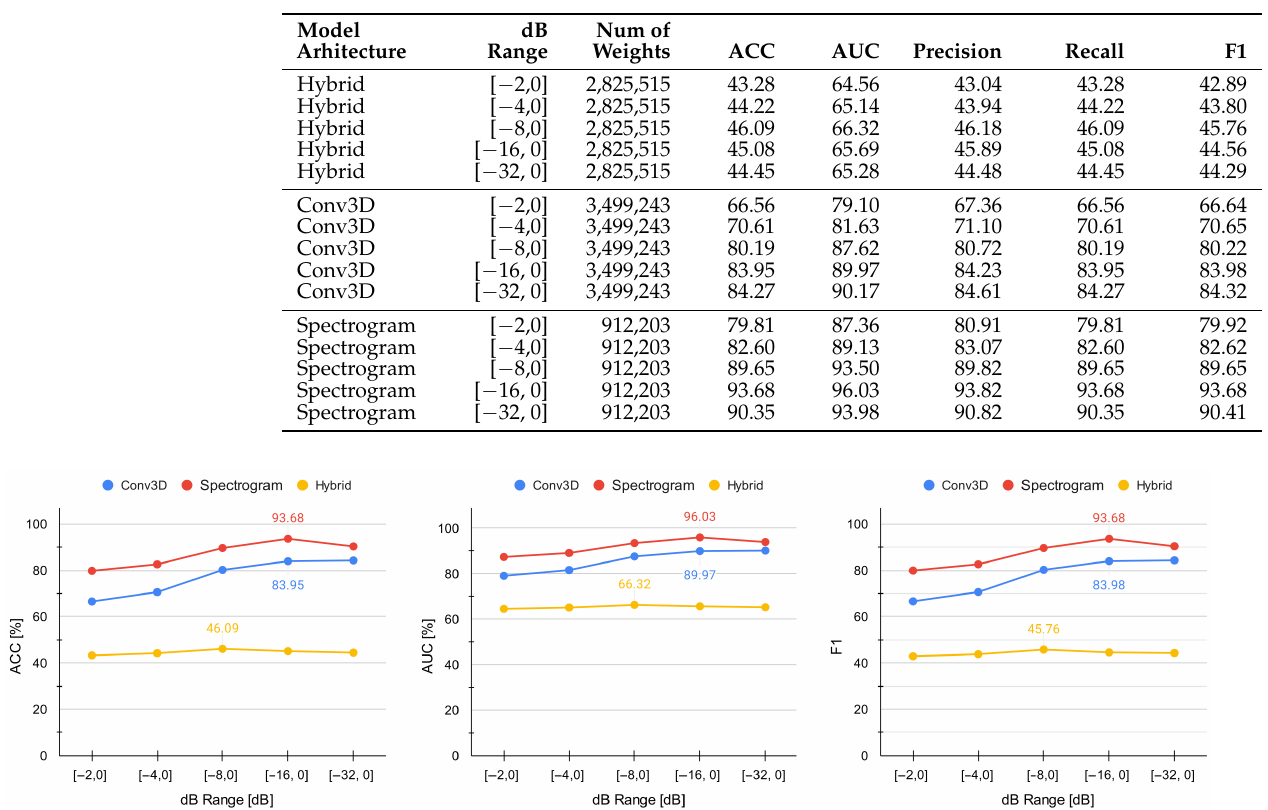
Table 2. Performance of different model architectures at varying dB range settings.